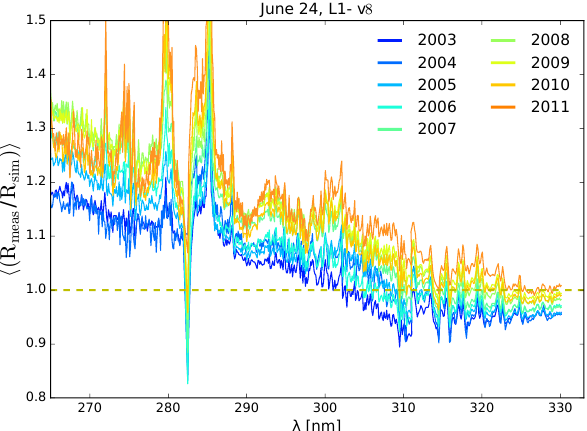
Figure 11. Mean ratio of observed ( R meas ) to simulated ( R sim ) re- flectance spectra for 1 day for each year. The varying rainbow spec- trum from blue to red colour labels the ratios for years 2003 to 2011. A horizontal line where the ratio is one is shown for